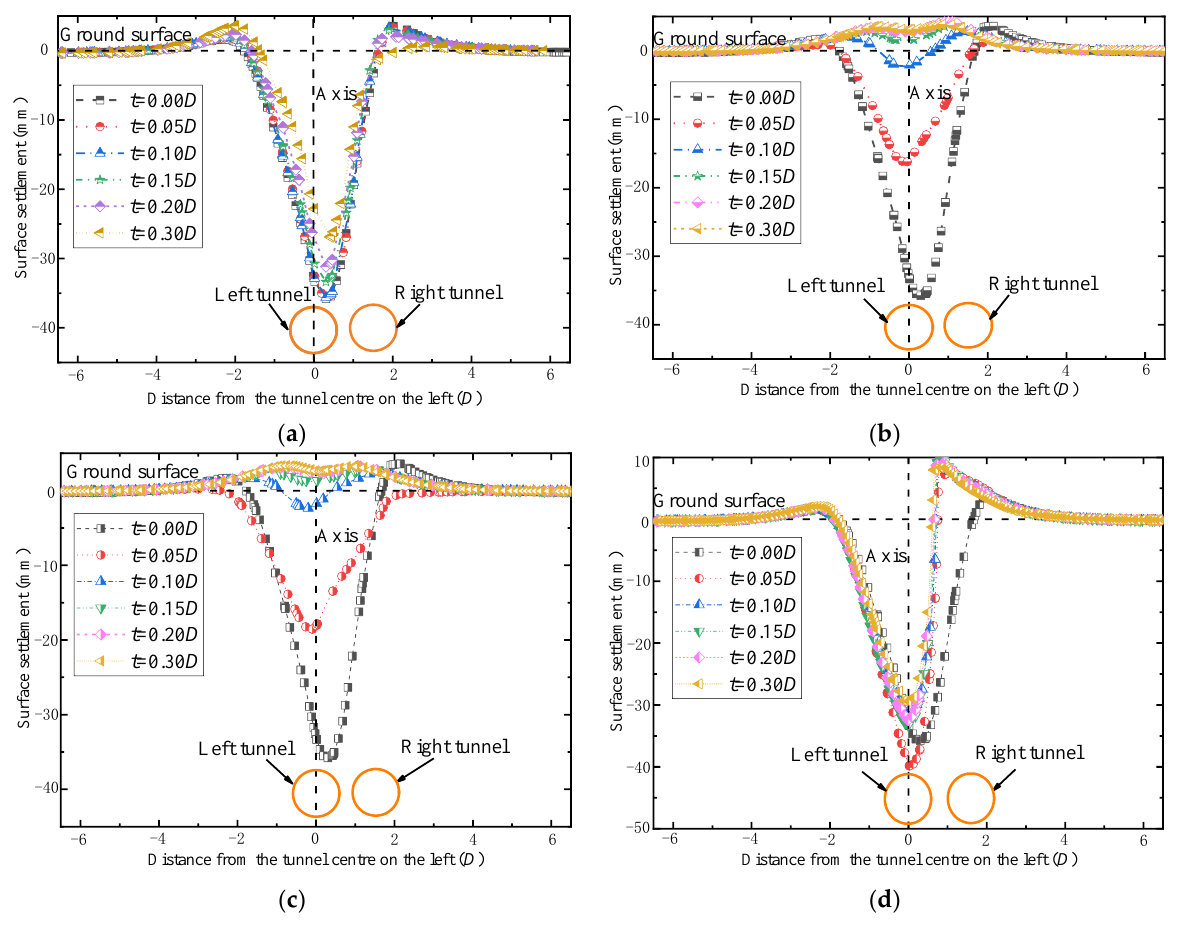
Figure 5. Settlement of ground surface at the transverse monitoring section : ( a ) RR; ( b ) LR; ( c ) TR; ( d ) CR.